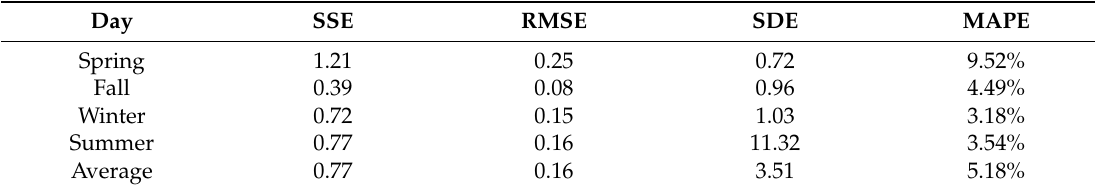
Table 5. Accuracy Analysis Summary—Stage 1.